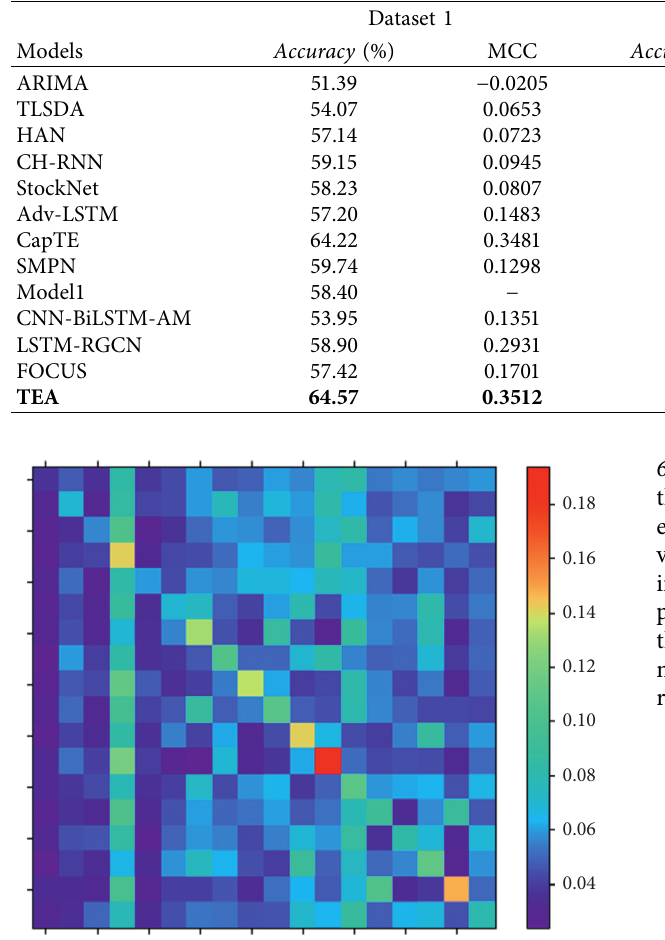
Figure 3: Visualization of attention